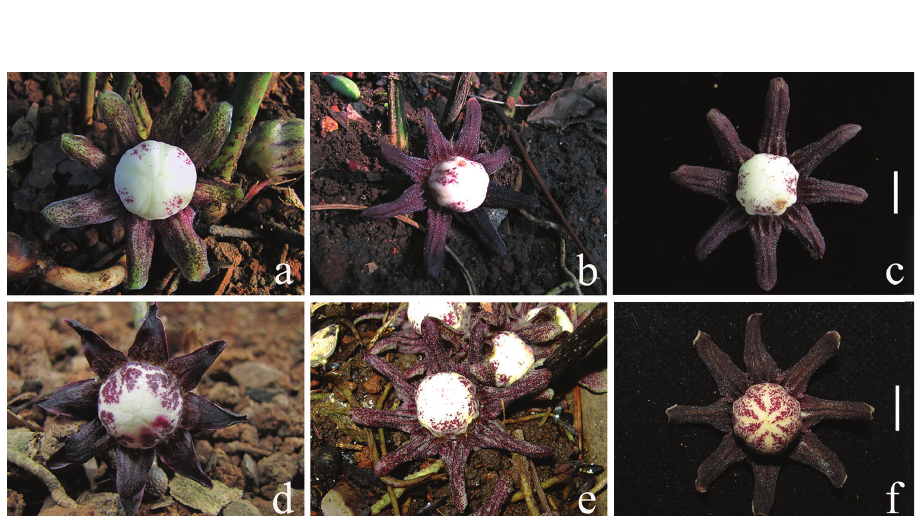
Figure 5. Flower morphology Aspidistra subrotata . a–c flowers of diploid plants from a Nonggang population b Nanning population c 4th boundary marker population d–f flowers of tetraploid plants from d, e Mt. Bavi population f Mt. Daqing population. Bar = 1